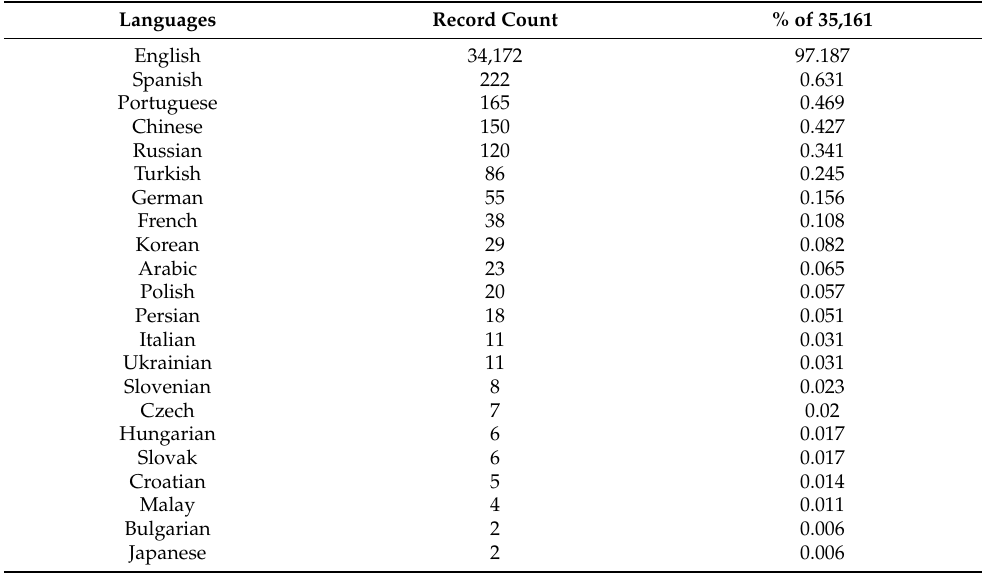
Table 13. Languages used as a medium for publications (2016–2018) for which publication count is >1.